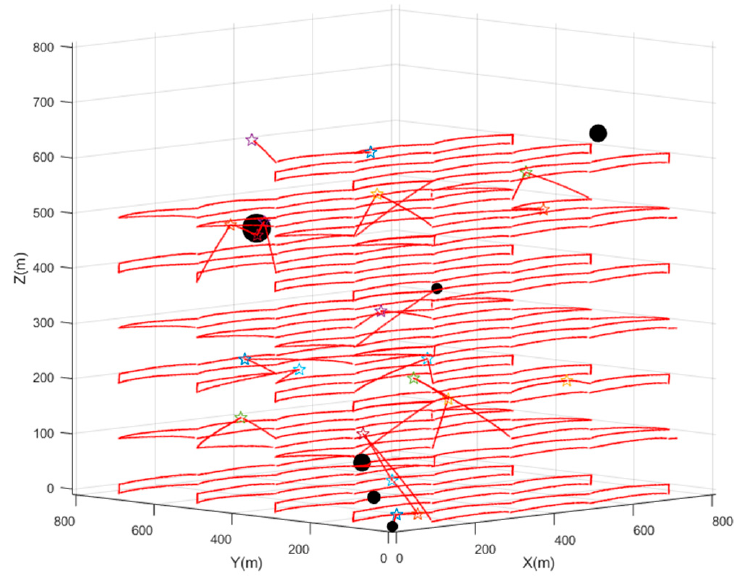
Figure 14. The search trajectory diagram of the coverage search algorithm.